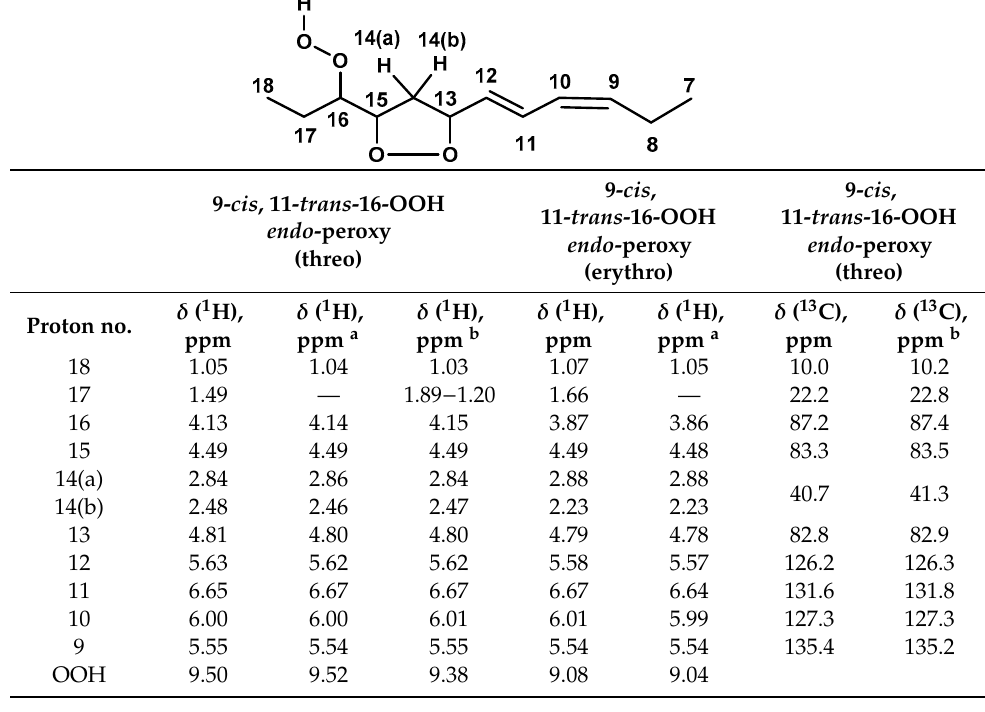
Table 3. 1 H-NMR quantification data of hydroperoxides and endo -hydroperoxides produced during the oxidation of methyl linolenate a